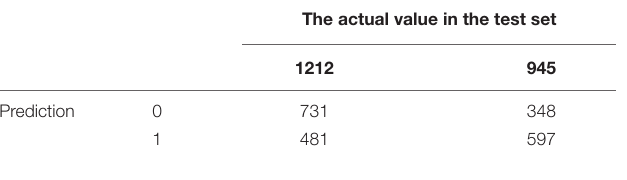
TABLE 3 | Confusion matrix of artificial neural